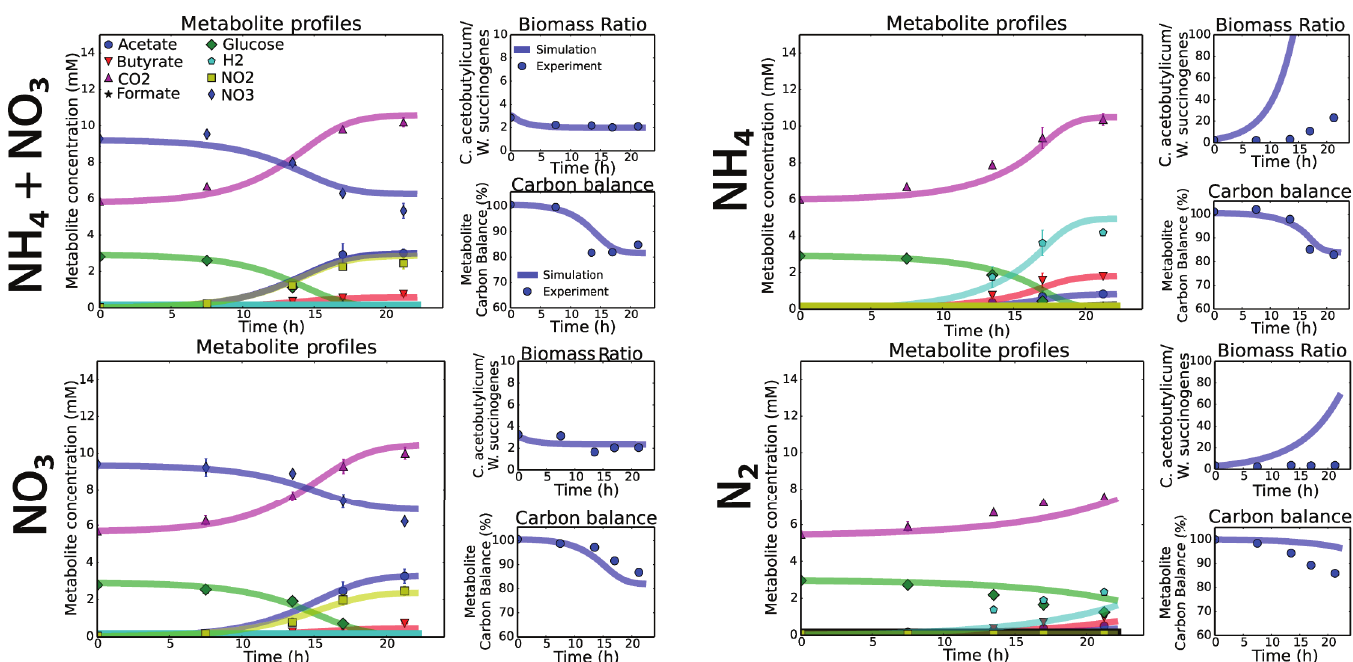
Fig 3. The dFBA simulations agree mostly with the experimental data for the four different cultivation conditions and were used to infer the metabolic fluxes. The metaboliteprofile plots containerror bars, but the other subplotsnot. The biomass ratios are basedon the gene-copydata and the carbonbalanceconsisted of the measuredmetabolitesthat containedcarbon. The remainingmissing carbon is assumed to be incorporated into